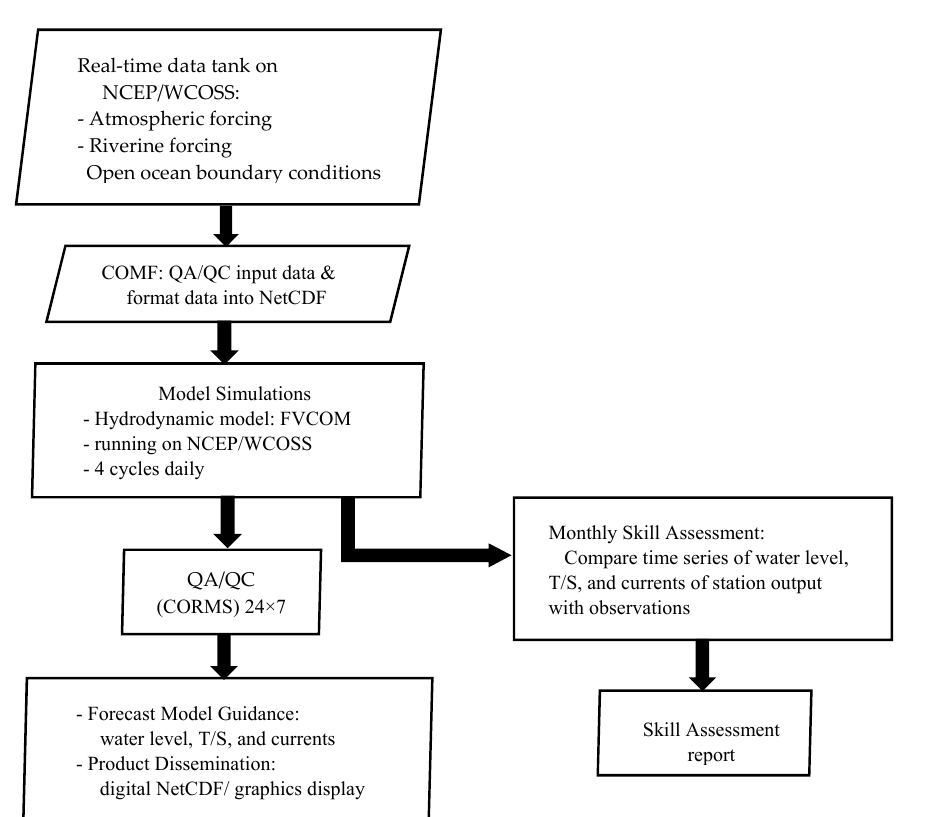
Figure 3. Conceptual structure and the operational and data analysis procedures of the NGOM operational forecast systems.